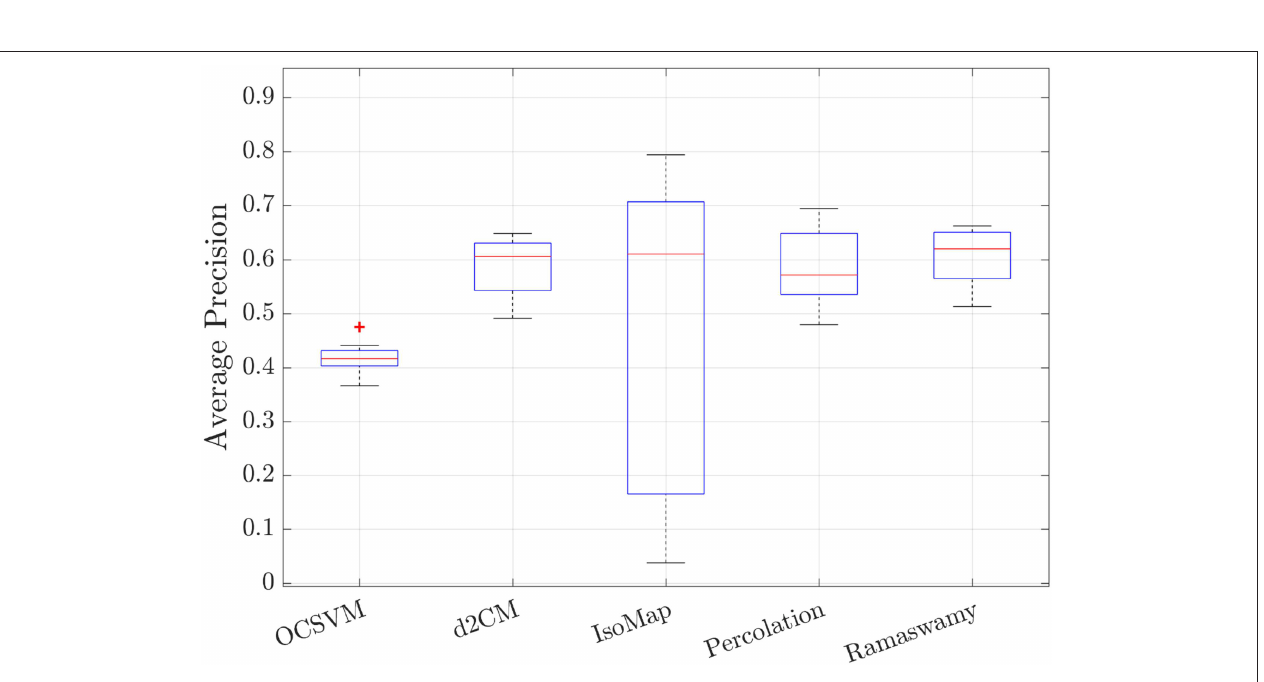
FIGURE 7 | Performance of all the outlier finding methods for the credit card transactions on the test subsets of the random groups. The random groups were generated by randomly choosing 3,900 normal transactions and 100 frauds, and it was further randomly divided into two subsets, a training and a testing